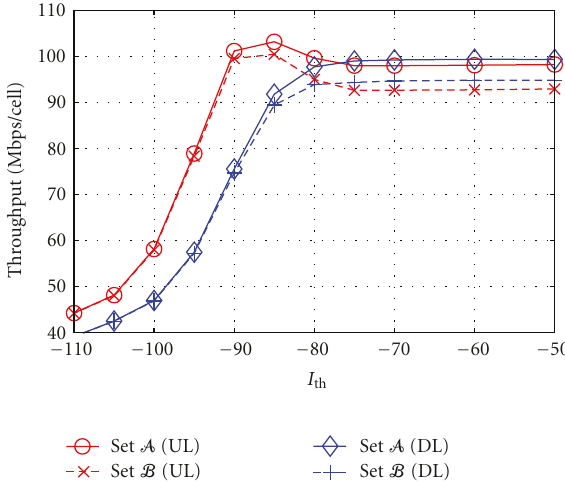
Figure 6: Mean system throughput versus I th for BB-OFDMA with 16-QAM modulation using fixed BB transmit power. The mean system throughput is maximised for I th = − 85 dBm in the UL and I th = − 75dBm in the